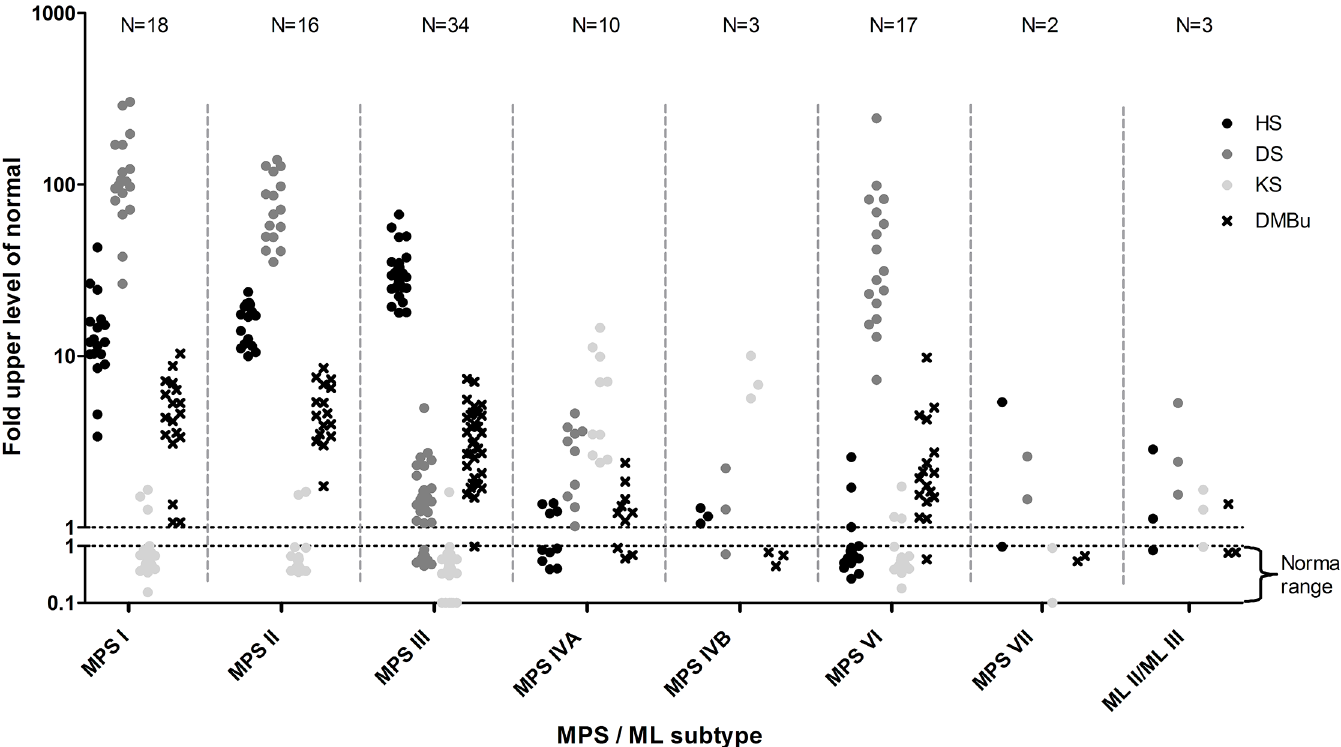
Fig 2. Concentrations of HS, DS and KS measured by multiplexed LC-MS/MS in confirmed MPS and ML patients. Values represent the